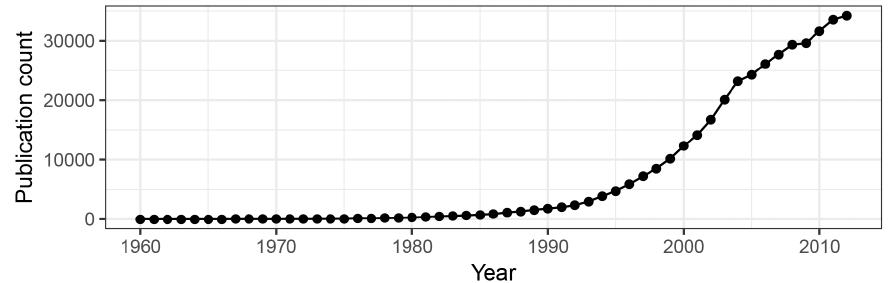
Figure 4 - Total number of publications by those who declared to work in Computer Science. This counting considers books, book chapters, articles in journal and publications (articles, extended abstracts, and abstracts) in conference